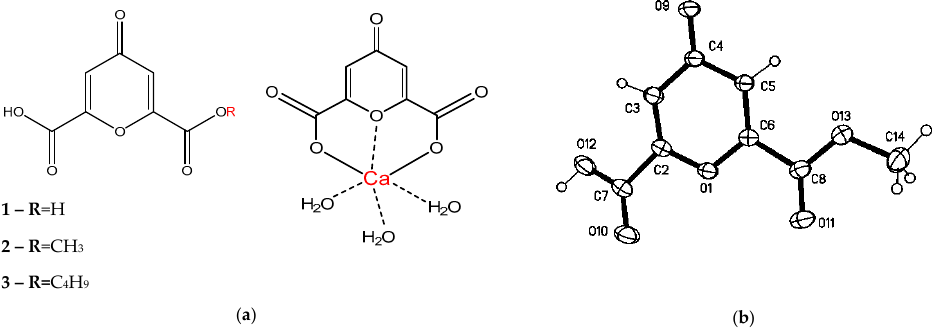
Figure 1. The structure of compounds 1–4 (a) and XRD structure of 2 (thermal ellipsoids are drawn at the 30% probability level) (b). the 30% probability level) ( b